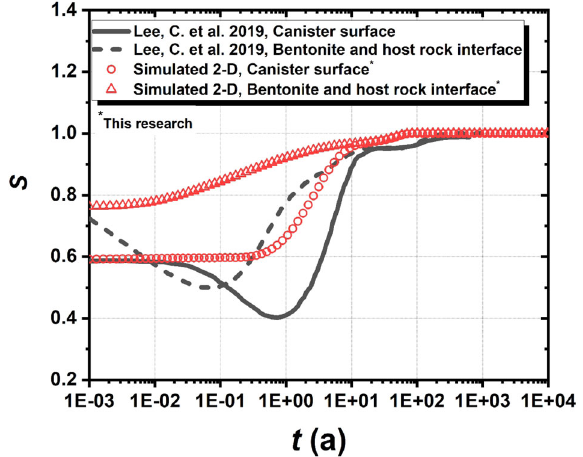
Fig. 9 Validation for degree of saturation pro fi le. Comparison of degree of saturation ( S ) between Lee et al. and our model for canister/bentonite and bentonite/host rock interfaces 35